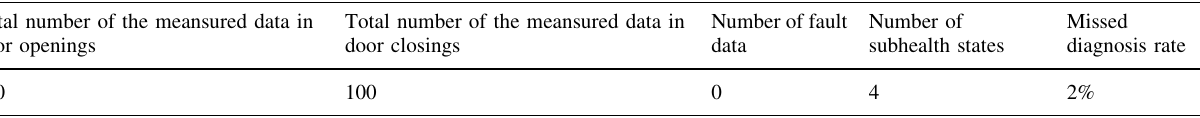
Total number of the meansured data in door closings